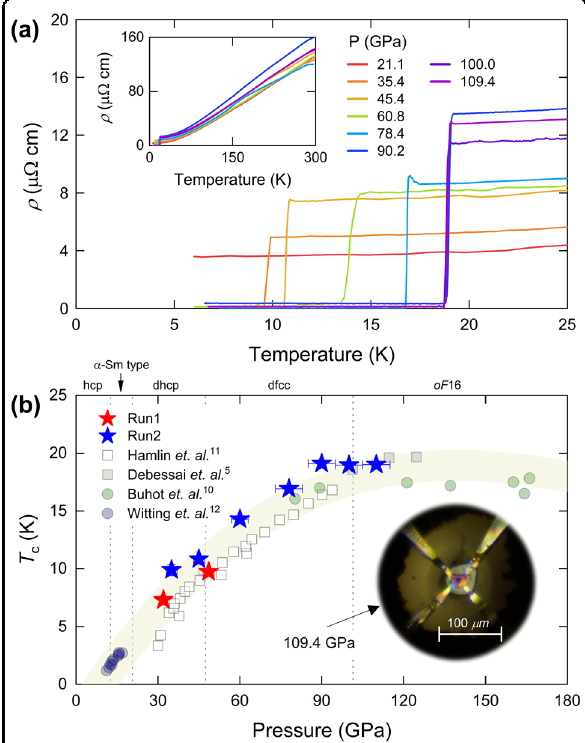
Fig. 1 Electrical resistivity and P-T phase diagram of Y at different pressures. a Pressure – temperature evolution of the resistivity of Y. The inset displays the resistivity over the entire temperature range (6 – 300 K) at which measurements were conducted at various pressures up to 109.4 GPa. b P-T phase diagram of Y obtained from resistivity (circle symbols) and ac susceptibility (square symbols) measurements under pressure. The star symbols refer to our resistivity data in the symmetric cell (blue) and miniature Be-Cu cell (red). The resistivity measurements of T c from references 10,12 are represented as navy and olive circles, respectively. T c collected from ac susceptibility measurements is indicated by square symbols 5,11 . The dashed lines indicate the structural phase boundaries measured at room temperature 13 . As the pressure increases, the phase transition sequence for the crystal structure is hcp – α -Sm type – dhcp – dfcc – o F 16. The inset shows a photograph of the van der Pauw con fi guration at